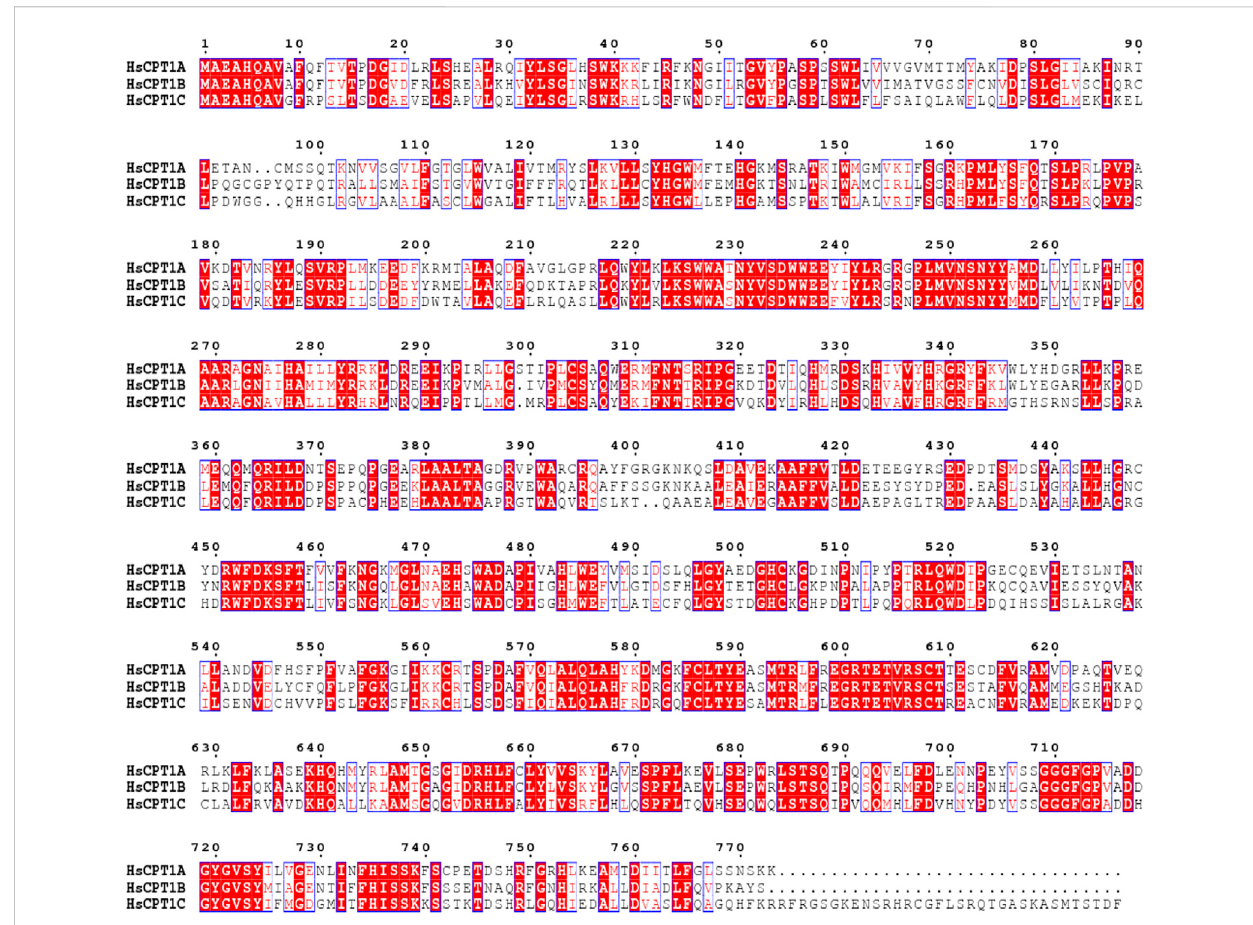
FIGURE 2 Multiple sequencealignmentwas performed byClustalW inMEGA11 software (Tamuraetal., 2021)and furthertreated byESPript webserver(Robert and Gouet, 2014). Sequence alignment of three CPT1 isoforms with strictly conserved amino acid residues highlighted in